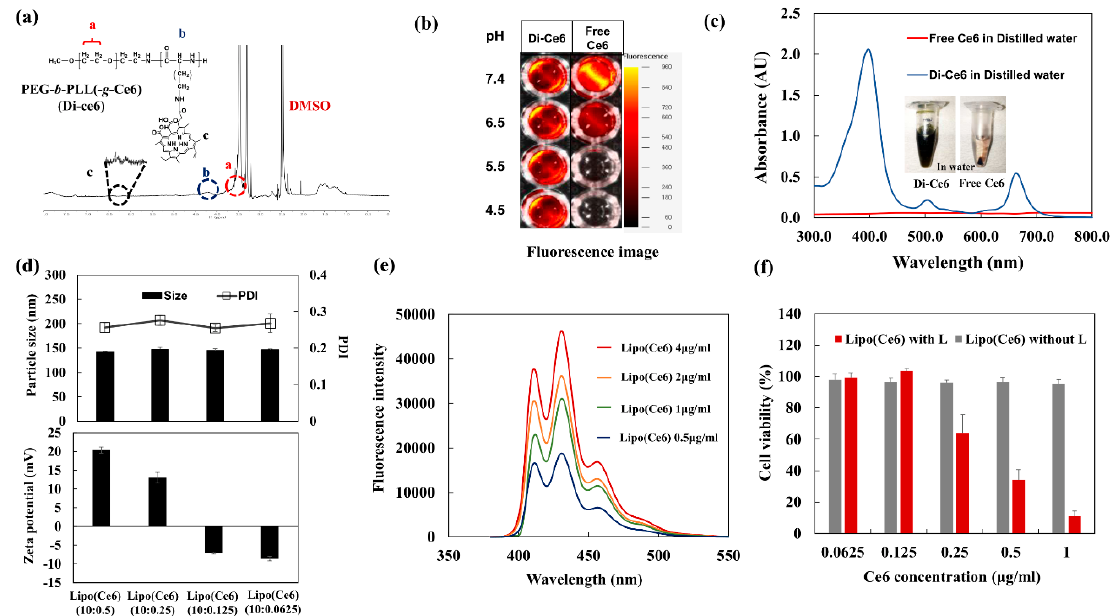
Figure 4. In vitro characterization of Lipo (Ce6); ( a ) 1 H NMR spectra of PEG-PLL(- g -Ce6) (Di-Ce6); ( b ) fluorescence image of Di-Ce6 and free Ce6 in PBS at different pH conditions; ( c ) UV-Vis spectrum scan of free Ce6 and Di-Ce6 in distilled water; ( d ) particle size, PDI and zeta potential of Lipo (Pep) at different loading ratio ( w / w ); ( e ) the 9,10-dimethylanthracene fluorescence change of Lipo (Ce6) at different Ce6 concentration (5.2 mV, 100s laser exposure time); ( f ) the cell viability of KB cells treated with Lipo (Ce6) or free Ce6 (5.2 mV, 100s laser exposure time).